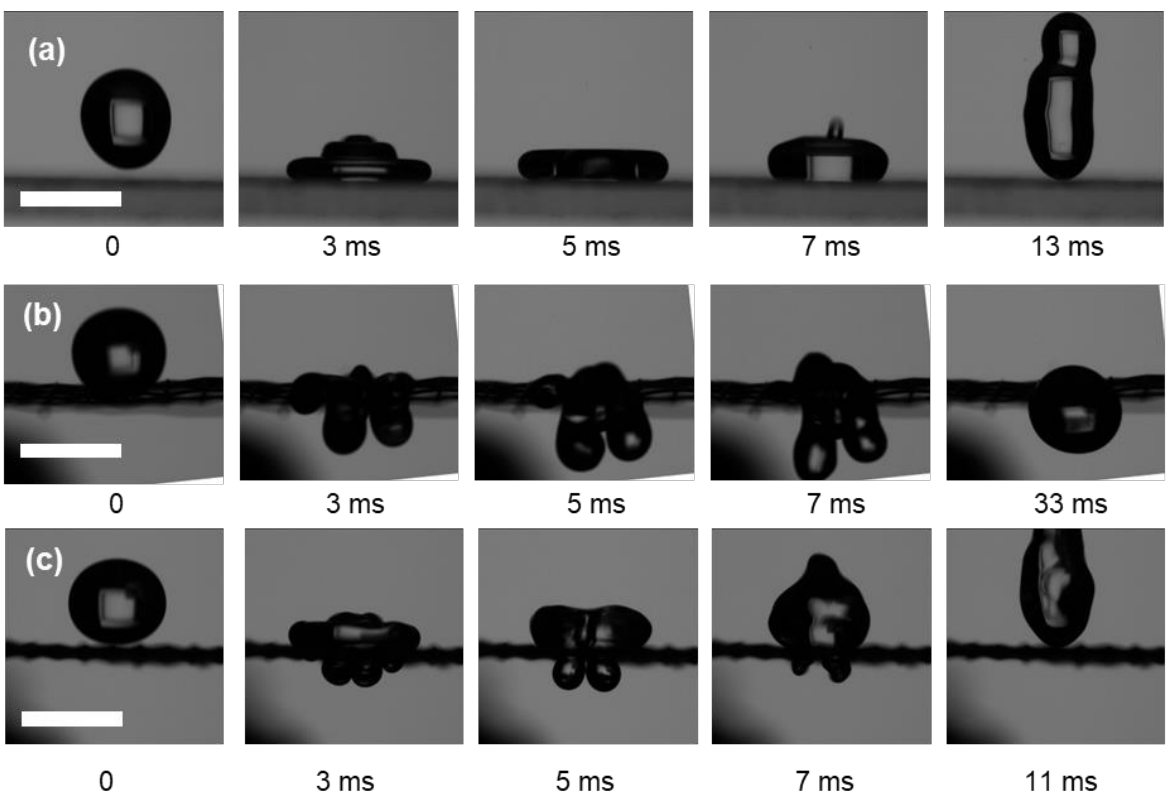
Figure 4. Impacting process of a droplet on different substrates. ( a ) Superhydrophobic substrate. ( b ) Hydrophilic mesh. ( c ) Superhydrophobic mesh. The mesh in ( b , c ) is NO. 2#. The impact speed of the droplet is 0.6 m/s. Scale bars are 3 mm.